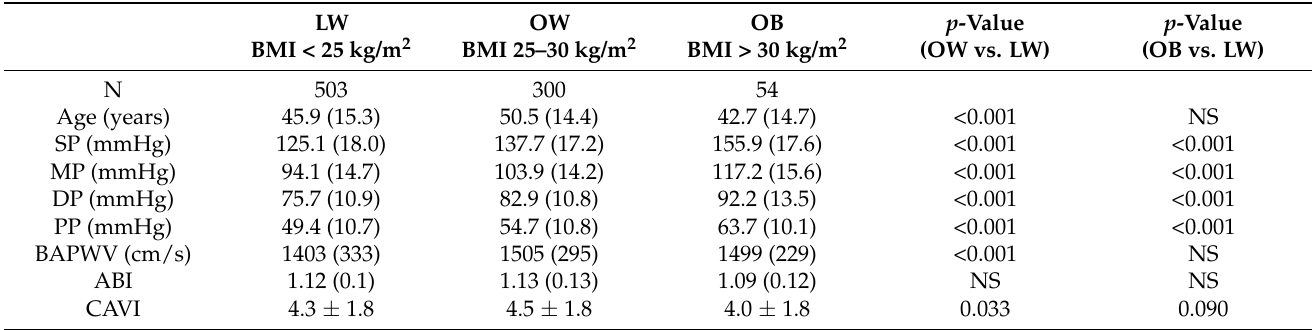
Table 1. Subjects’ characteristics grouped according to their BMI (mean ± SD).